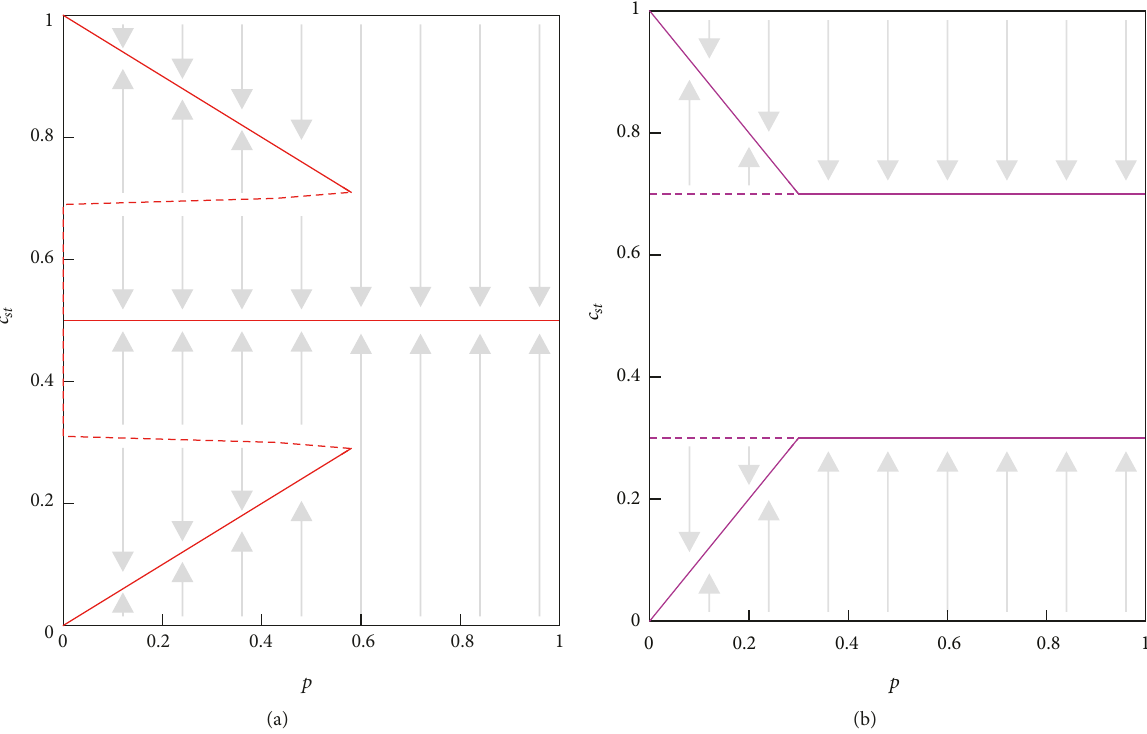
Figure 4: Flow diagrams for the threshold model with 𝑟 = 0.7 with (a) independenceand (b) anticonformity. Solid lines indicatestable steady states, whereas dashed lines represent unstable ones. Arrows indicate the direction of flow in the space of parameters (𝑐(0), 𝑝)